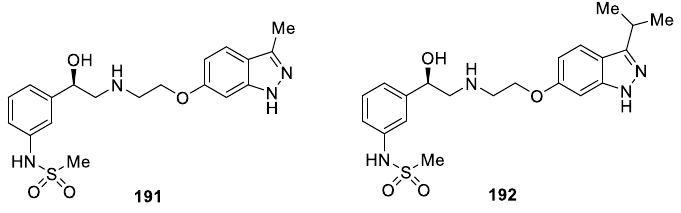
Figure 64. Chemical structures of N-substituted prolinamido indazole derivatives 188 , 189 and 190.